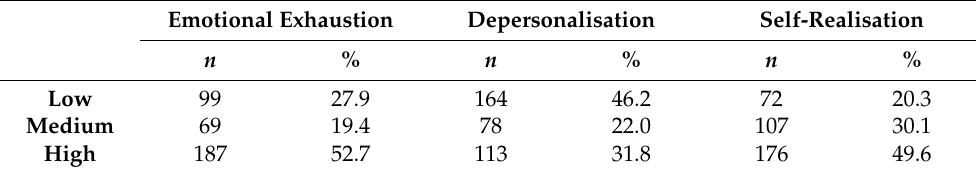
Table 2. Frequencies and percentages of MBI results according to